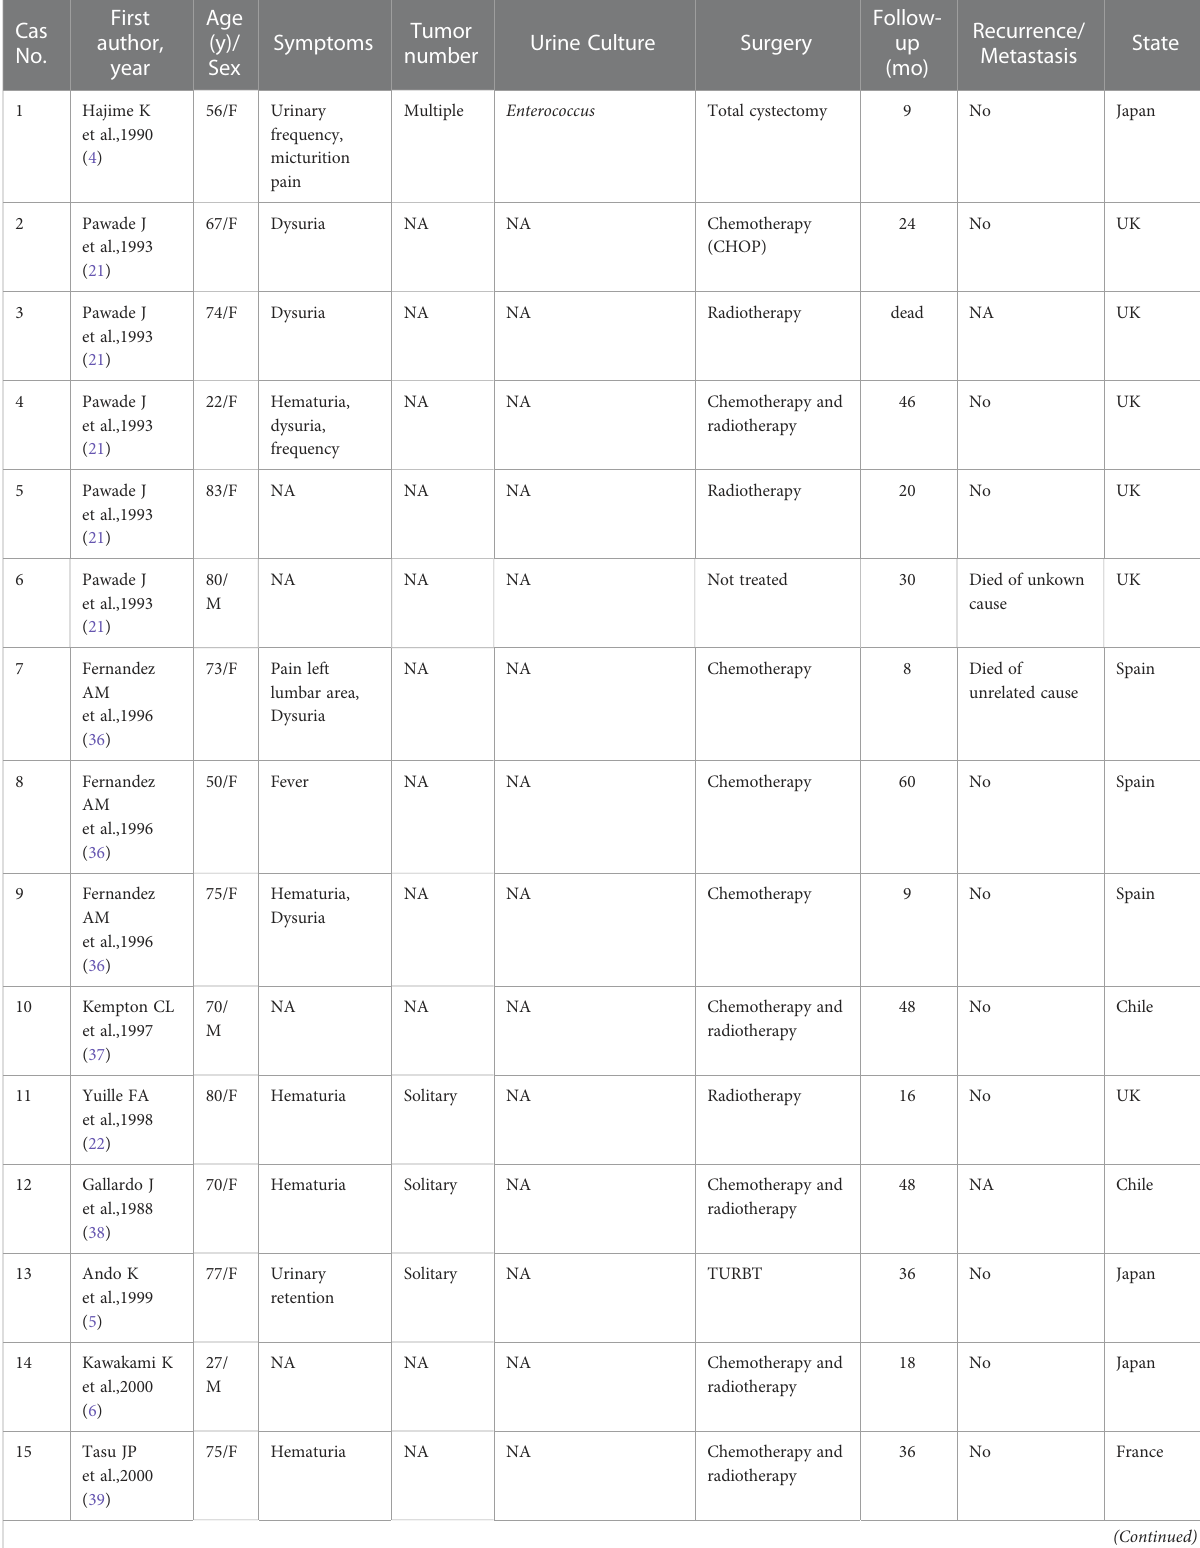
TABLE 1 Review of characteristics of primary bladder mucosa-associated lymphoid tissue lymphoma.